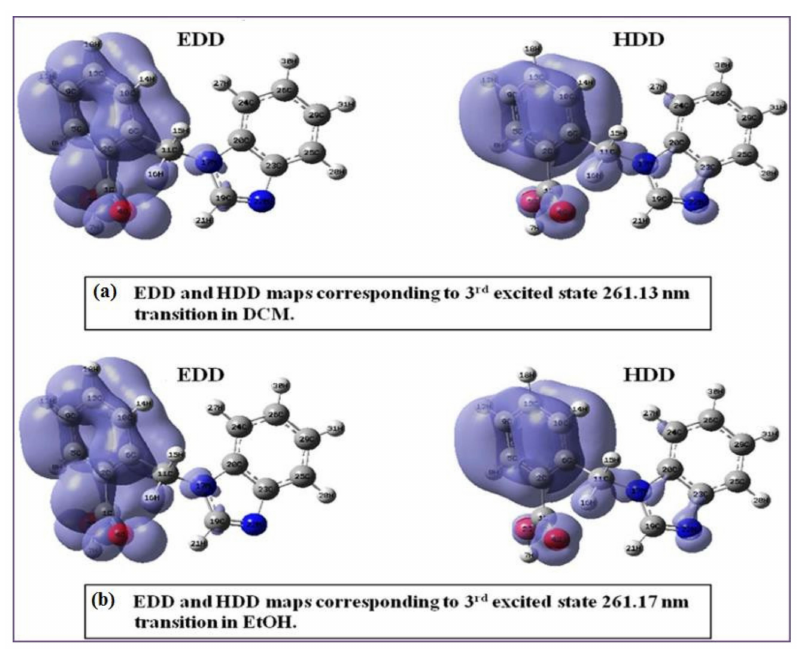
Figure 9. EDD and HDD maps of the 3rd excited state of 21HBMBA in ( a ) DCM and ( b )